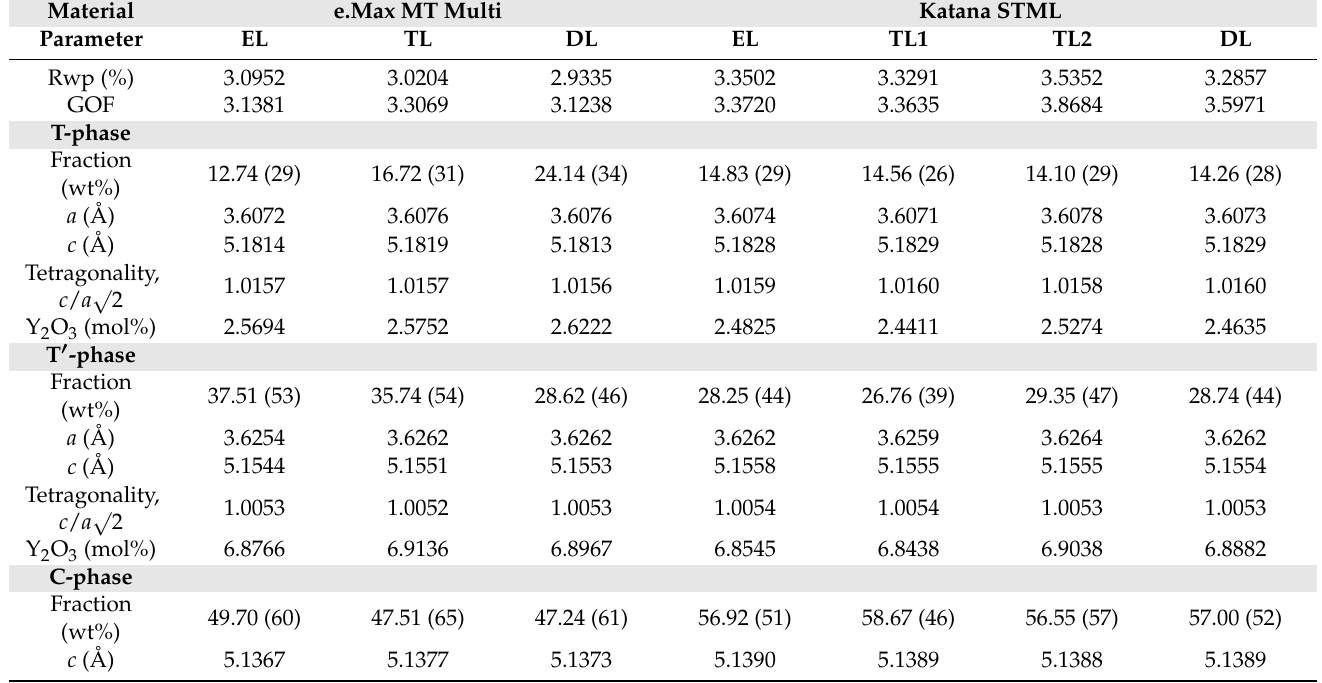
Table 5. Rietveld analysis results of XRD patterns for each